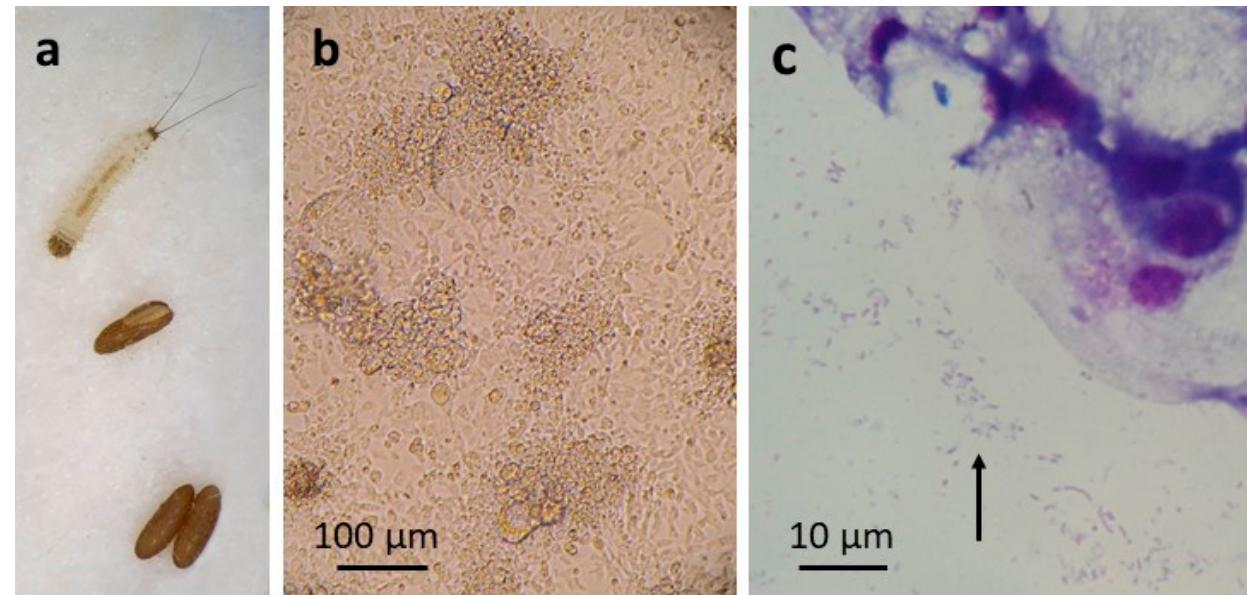
Figure 2. Phlebotomus papatasi cell line PPL/LULS49. ( a ) P. papatasi eggs (bottom), empty eggshell (centre) and first instar larva (top). ( b ) PPL/LULS49 cells at passage 9, 15 months after initiation; live, inverted microscope. ( c ) PPL/LULS49 cells showing extracellular Wolbachia (arrow); Giemsa-stained cytocentrifuge smear.